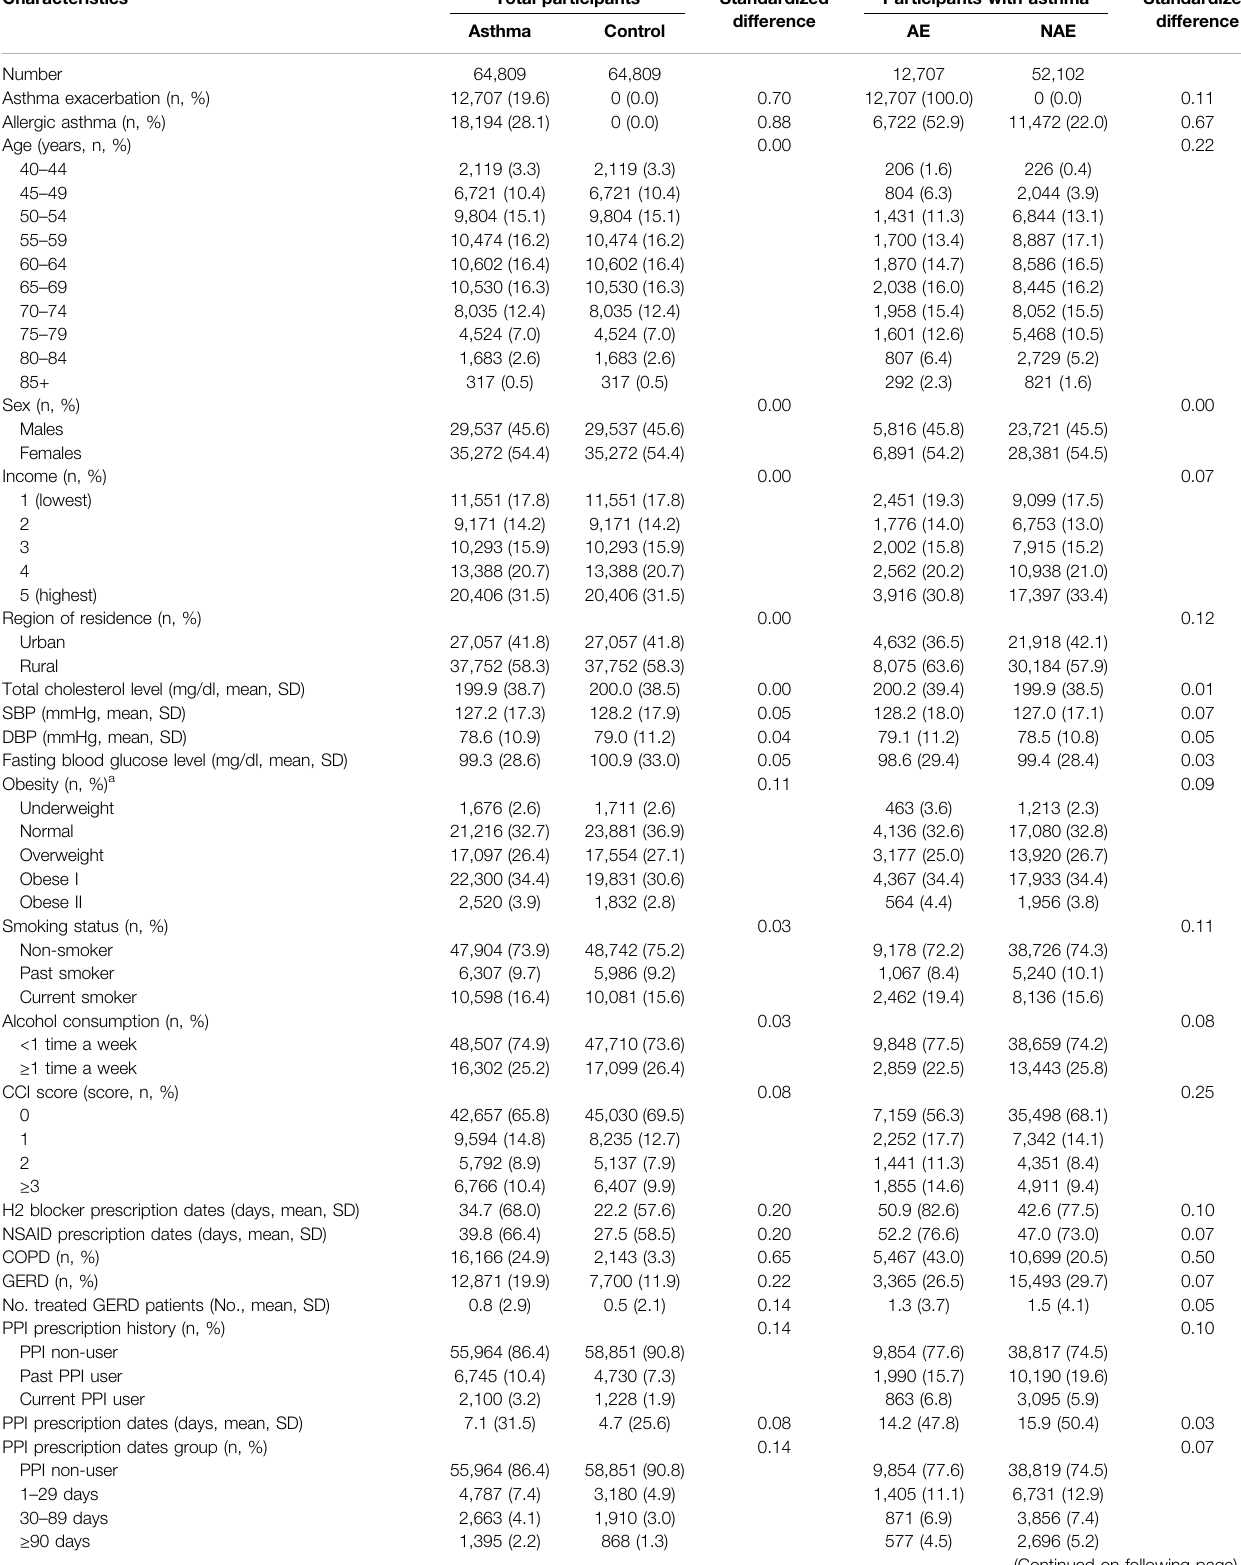
TABLE 1 | General characteristics of participants.